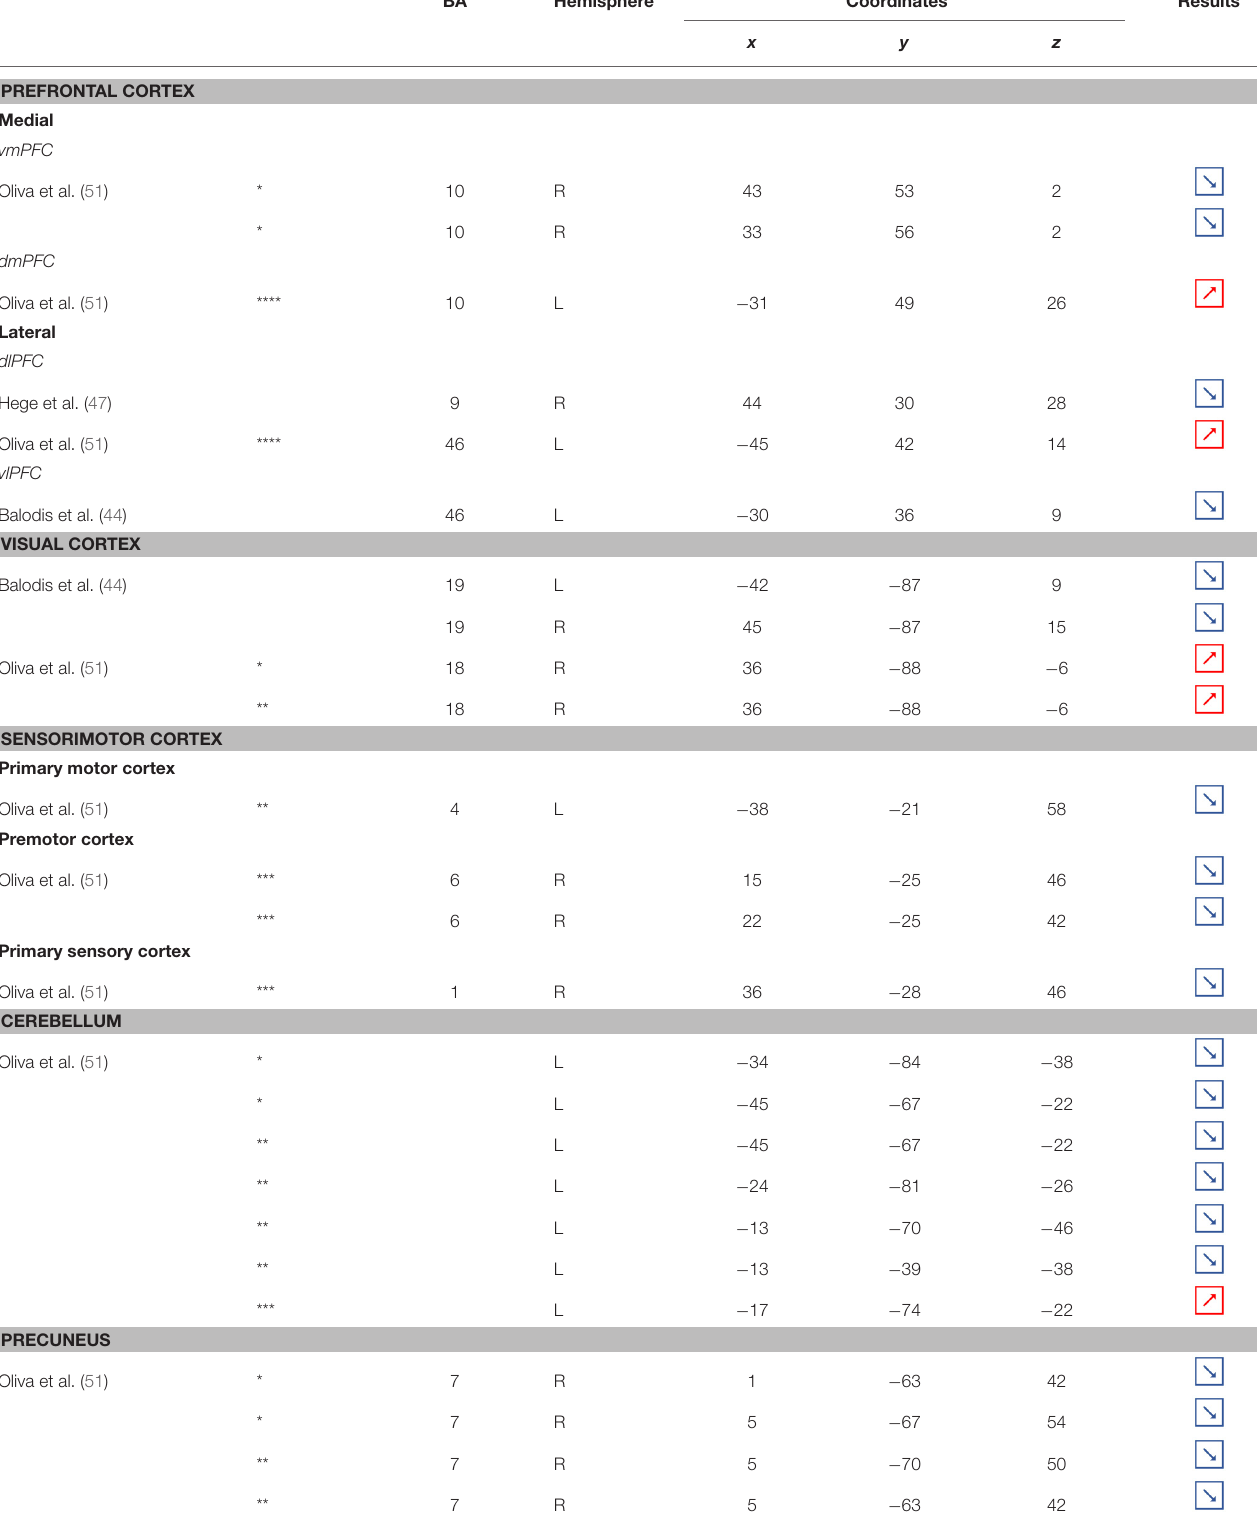
TABLE 6 | Regions showing different patterns of activity during inhibition in obese individuals with binge eating disorder in comparison with individuals without. BA Hemisphere Coordinates Results x y